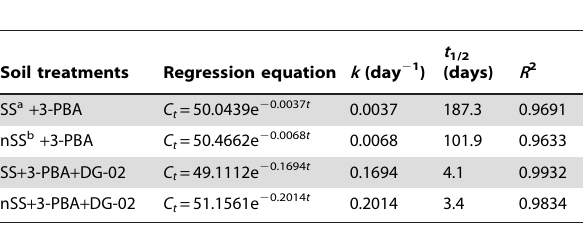
Table 5. Kinetic parameters of degradation of 3-PBA in different contaminated soils by strain